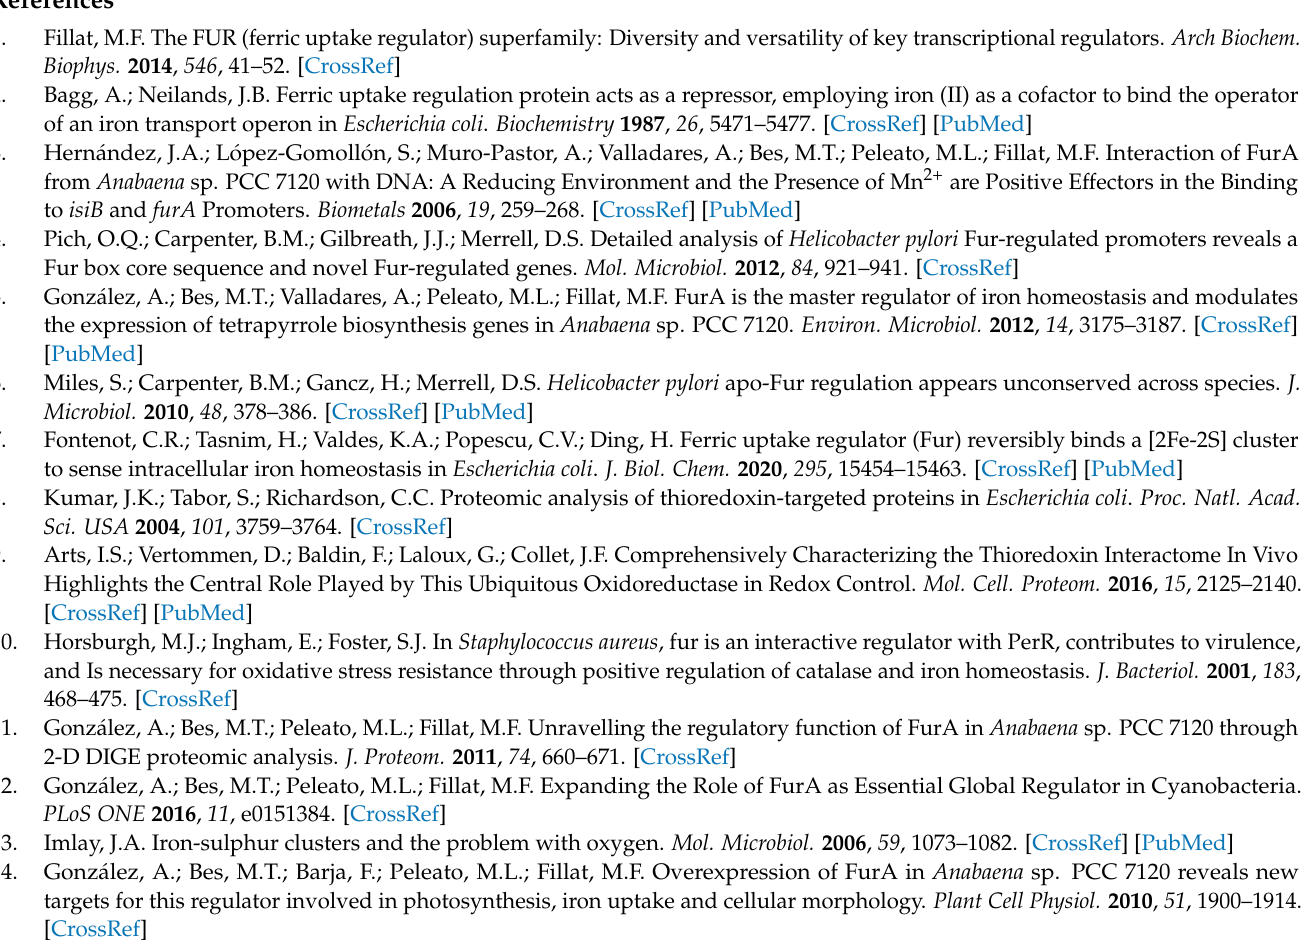
Figure S2: Reconstitution of the pathway of electron transfer NADPH->NTR->TrxA->FurA shows that FurA is reduced by TrxA, Figure S3: Reduction of FurA C101-C104 disulfide bridge by